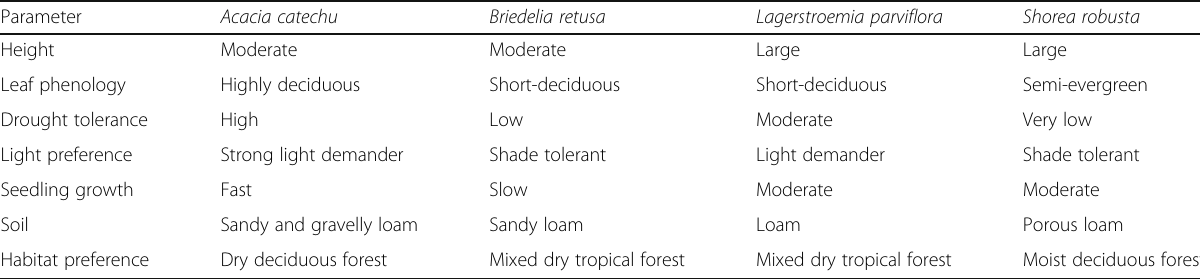
Table 2 Characteristics of selected species based on Troup (1921), Verma et al. (1993), and Singh et al. (2003) Parameter Acacia